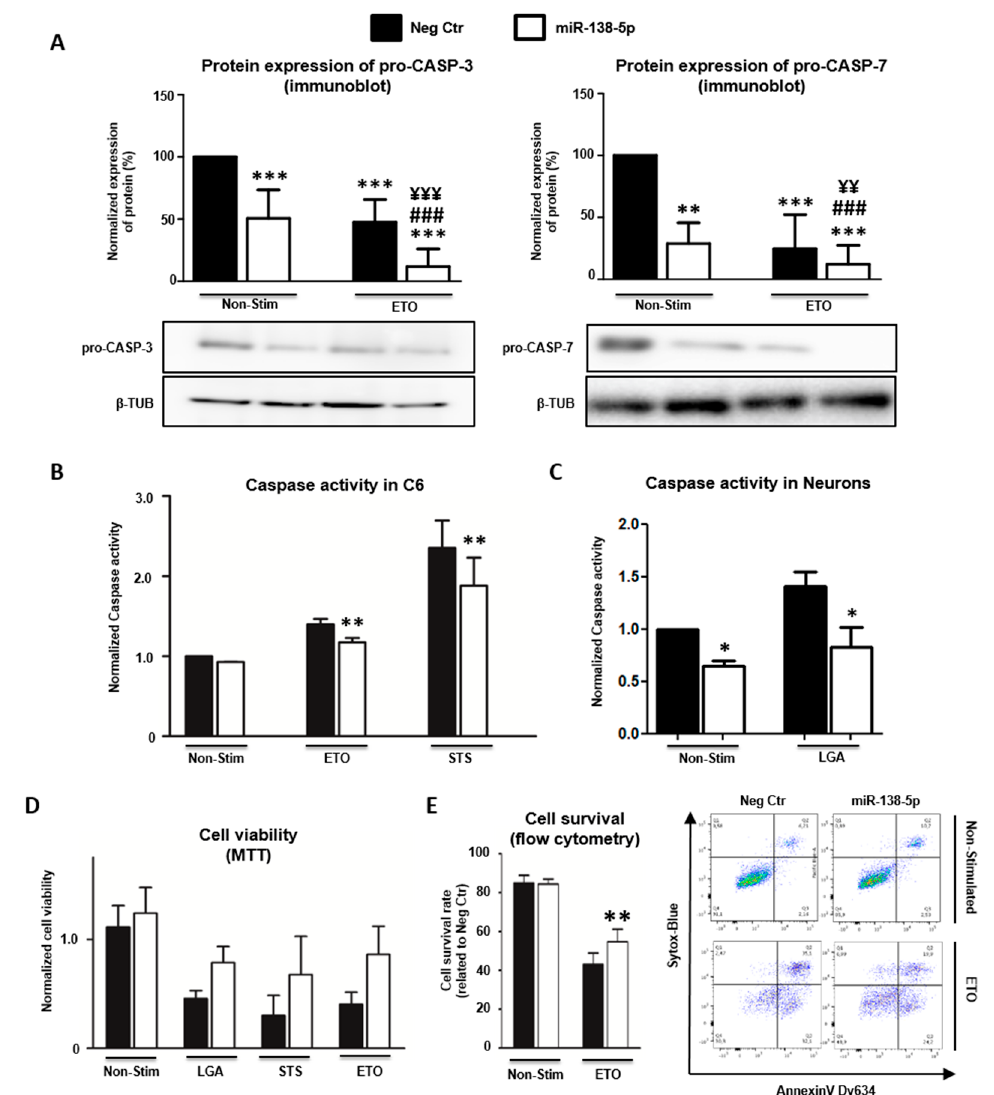
Figure 7. MiR-138-5p attenuates caspase-dependent apoptosis: ( A ) Protein expression of pro-CASP-3 and pro-CASP-7 in C6 cell cultures transiently transfected with miR-138-5p (white) or negative control (Neg Ctr, black) mimics and stimulated with ETO. Differences among conditions were calculated using the Kruskal–Wallis rank-sum test followed by Conover’s all-pairs post hoc test. ** and *** denote a significant difference ( p < 0.01 and p < 0.001, respectively) relative to Neg Ctr; ### denote a significant difference ( p < 0.001) relative to miR-138-5p-treated cultures; ¥¥ and ¥¥¥ denote significant differences ( p < 0.01 and p < 0.001, respectively) relative to Neg Ctr + ETO-treated cultures. Bars represent the mean ± SD of, at least, four independent experiments. Complete blot images are available at OSF (https://osf.io/yqn58/, accessed on 24 May 2022). ( B ) Effects of miR-138 transfection on the activity of the effector CASP-3 and CASP-7 in C6 cell cultures before and after ETO and STS stimulation. Differences among conditions were calculated using a non-parametric Kruskal – Wallis test followed by a Conover post hoc test. Values correspond to the mean ± SD and ** denotes a significant difference ( p < 0.01 and p < 0.001, respectively) relative to the corresponding cultures treated with the same stimulation and transfected with Neg Ctr. ( C ) Caspase activity in hippocam- pal neurons transfected with miR-138-5p or negative control before and after LGA stimulation. Dif- ferences among treatments were analyzed using a paired two-way ANOVA. Bars represent the av- erage ± SD and * denotes a significant difference ( p < 0.05) relative to the corresponding cultures treated with the same stimulation and transfected with Neg Ctr. ( D ) MTT assay of C6 cell survival after transfection with miR-138-5p and negative control mimics under different apoptotic stimula- tions. Differences among conditions were analyzed using a paired two-way ANOVA. Bars represent the mean ± SD of three independent experiments. ( E ) A representative flow cytometry experiment